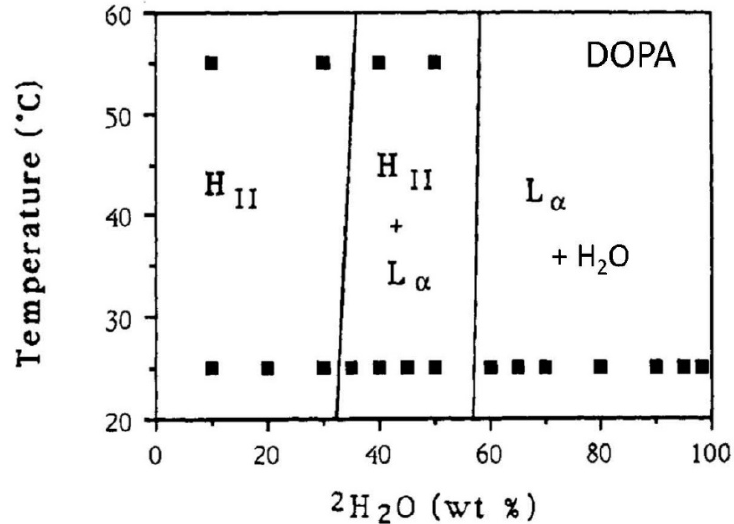
Figure 13. Aqueous dispersions of the mono-anionic form of DOPA. Tentative binary DOPA/water phase diagram, according to Lindblom et al. (1991) [113]. In the diagram shown, H 2 O was added in the high water content region as second phase (L α + H 2 O); H 2 O was omitted in the originally published diagram. Reproduced with permission from [113], American Chemical Society,